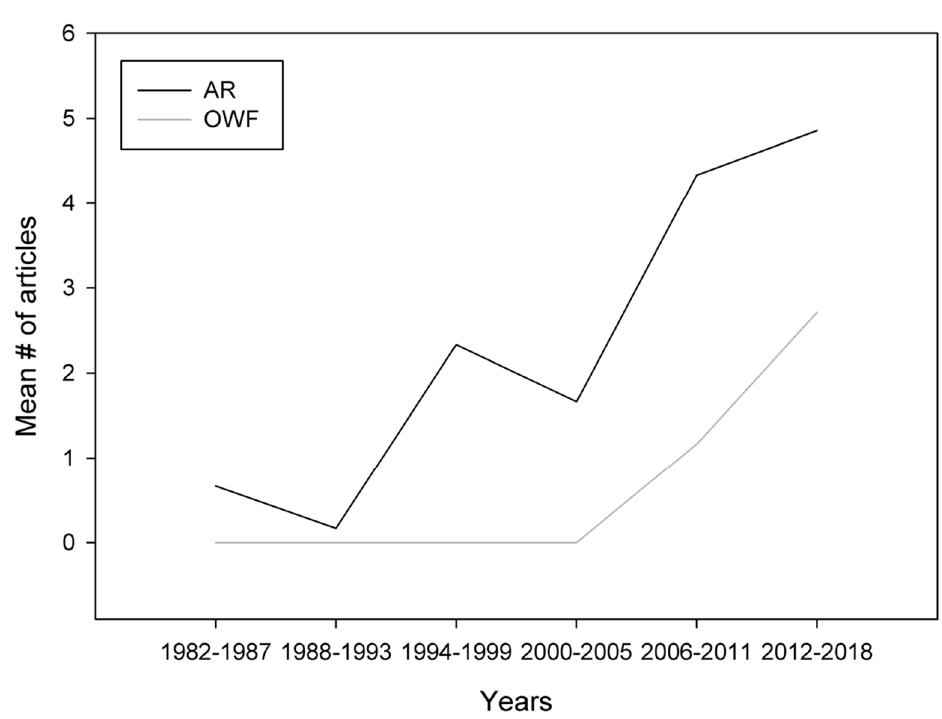
Figure 3. Trends of research output (articles per year) for artificial reef (AR) and offshore wind farm (OWF) studies through the years 1982–2018 (source: Web of Science, Scopus). For clarity, data are presented in six-year intervals, with the exception of the 2012–2018 period, which includes seven years. This unequal division was necessary to address the total period of 37 years that contained all articles fulfilling the inclusion criteria. Regardless of the duration of the time interval (six or seven years), data are presented as the mean number of articles per year from each time interval.